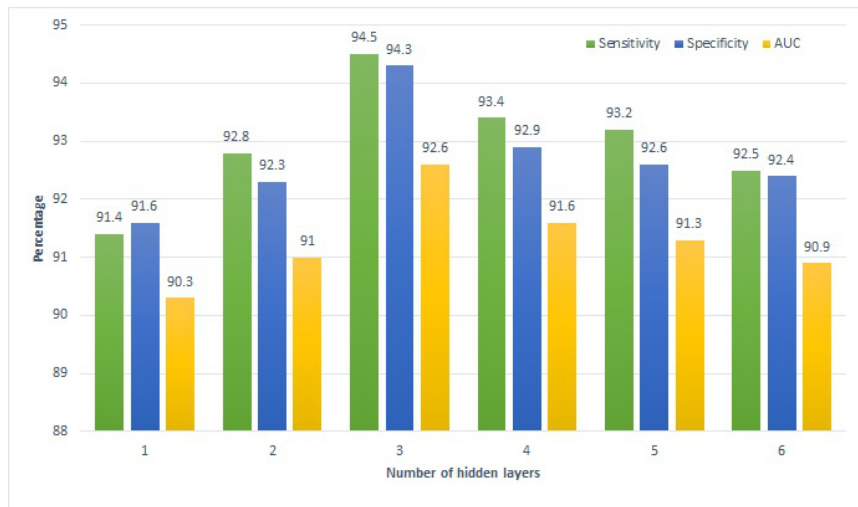
Figure 5. Performance of the proposed approach on school tutoring.